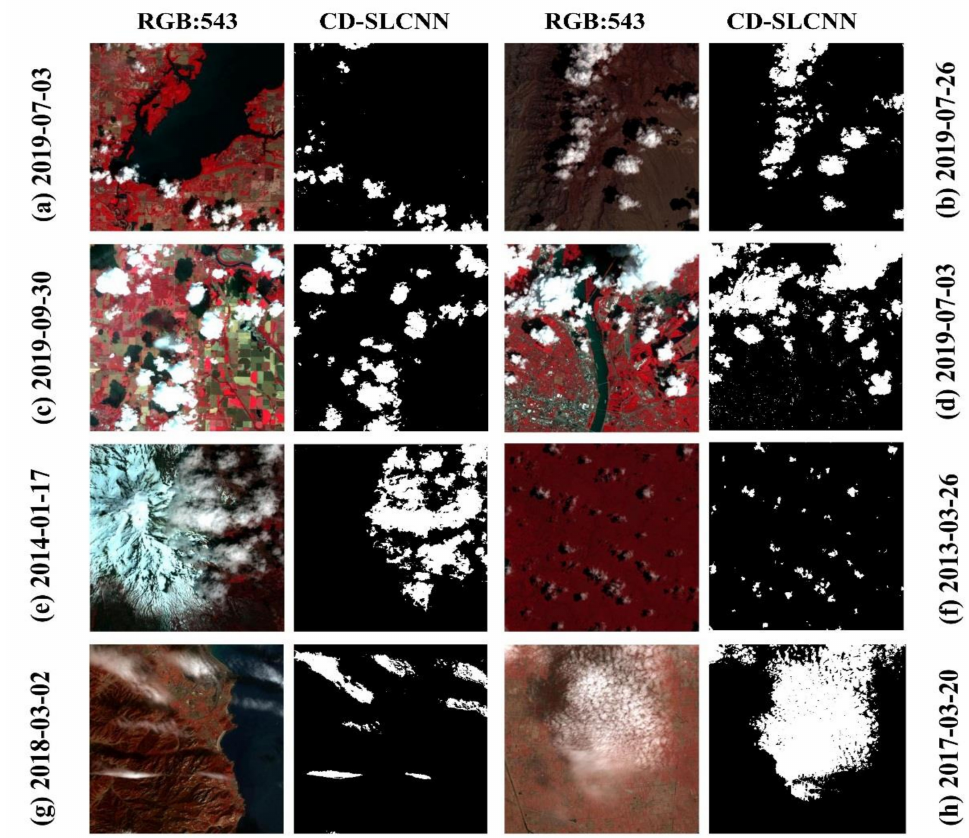
Figure 7. Examples of false-colour composite images and cloud (masked as white) detection results for Landsat-8 subimages over diverse underlying surfaces: ( a ) vegetation and inland water areas; ( b ) bare soil areas; ( c ) cultivated land areas; ( d ) urban area areas; ( e ) snow/ice areas; ( f ) vegetation areas; ( g ) rock and ocean areas; ( h ) vegetation and urban areas. The annotations on the left and right sides indicate the acquisition